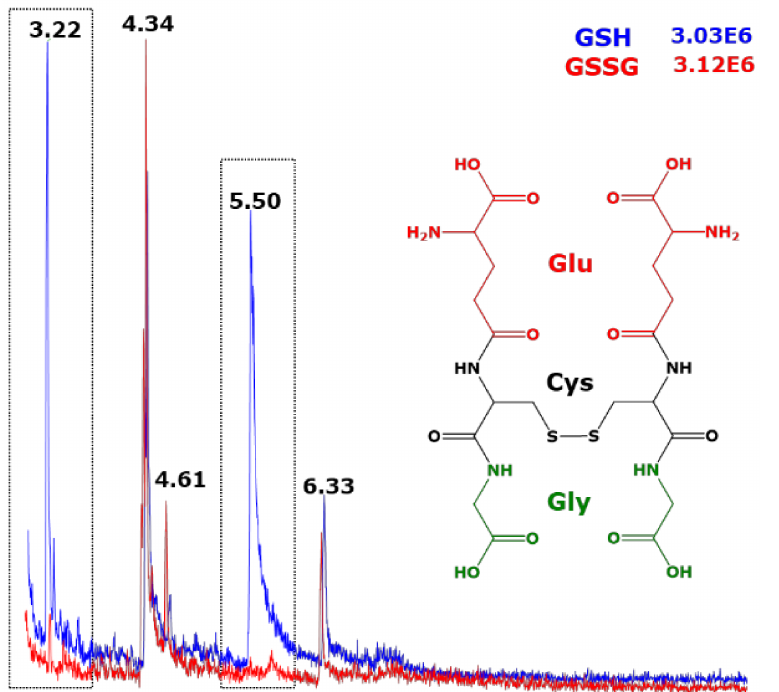
Figure 9. Overlaid total ion current GC-MS chromatograms in the ECNICI mode from separate analyses of synthetic reduced glutathione (GSH, blue colored) and synthetic glutathione disulfide (GSSG, red colored) (each 10 nmol) after esterification (60 min, 80 ◦ C) in 2 M HCl/CH 3 OH, and subsequent acylation with PFPA (30 min, 65 ◦ C). The quadrupole was scanned in the m / z -range 100–800 (1 scan/s). Oven temperature program TP#1 was used. Insert indicates the chemical structure of GSSG. Color within the GSSG structure was used for the amino acid components of GSSG. The numbers 3.03E6 (i.e., 3.03 × 10 6 ) and 3.12E6 (i.e., 3.12 × 10 6 ) indicate the total ion current in